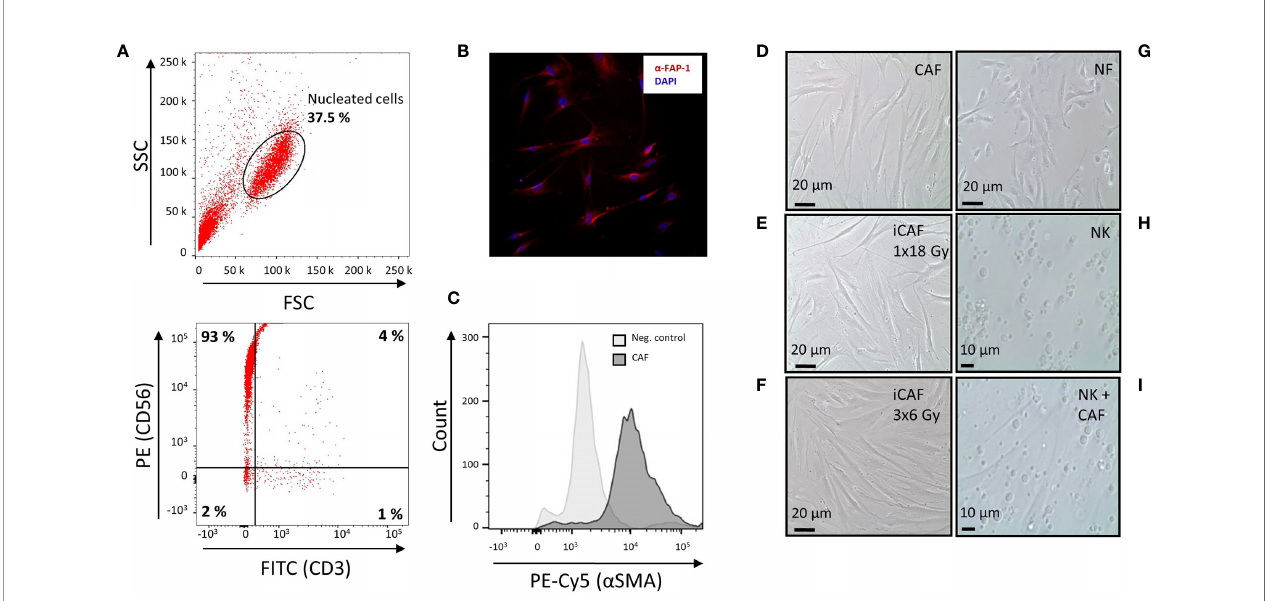
FIGURE 1 | Natural killer (NK) cell purity, cancer-associated fi broblast (CAF) characterization, and radiation-induced morphological changes in CAFs. (A) Dot plots from fl ow cytometer analyses, illustrating 93% purity of NK cells de fi ned as CD56 + CD3 − upon negative selection by antibody-coated microbeads. (B) Immunostaining of cultivated CAFs, using CAF-speci fi c FAP-1 antibody (red) and nuclear DAPI (blue). (C) Flow cytometry analyses of CAFs after immunostaining with CAF-speci fi c a SMA antibody. Negative control is CAFs stained with isotype control antibody. (D) Representative culture of spindle-shaped, non-irradiated human lung CAFs at passage three. (E) Representative image of CAFs acquired 5 days after exposure to ionizing radiation (1x18 Gy). (F) Image of irradiated CAFs in culture, acquired 2 days after third dose of 6 Gy (3x6 Gy). (G) Culture of normal skin fi broblasts (NFs). (H) Image of non-adherent (CD56 + CD3 − ) NK cells in monoculture. (I) Image of co-cultures consisting of adherent CAFs and non-adherent NK